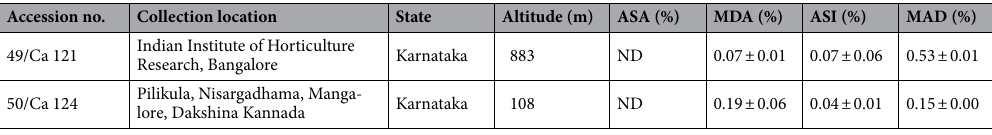
Table 1. Quantitative analyses of ASA, MDA, ASI and MAD in fifty accessions of CA, originally collected from various agro-climatic regions of south India and vegetatively propagated and maintained in a Field Gene Bank under identical environmental conditions for six generations. ND—not detected; each percentage is an average of six values ± SD.